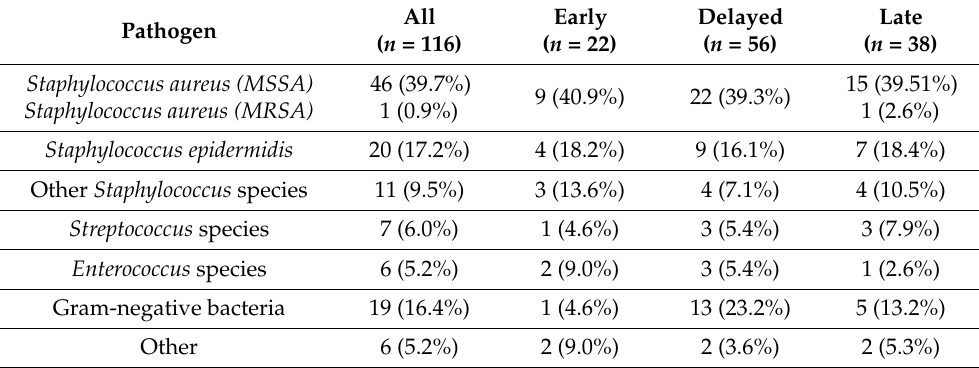
Table 2. Isolated microorganisms overall, and early, delayed and late FRI